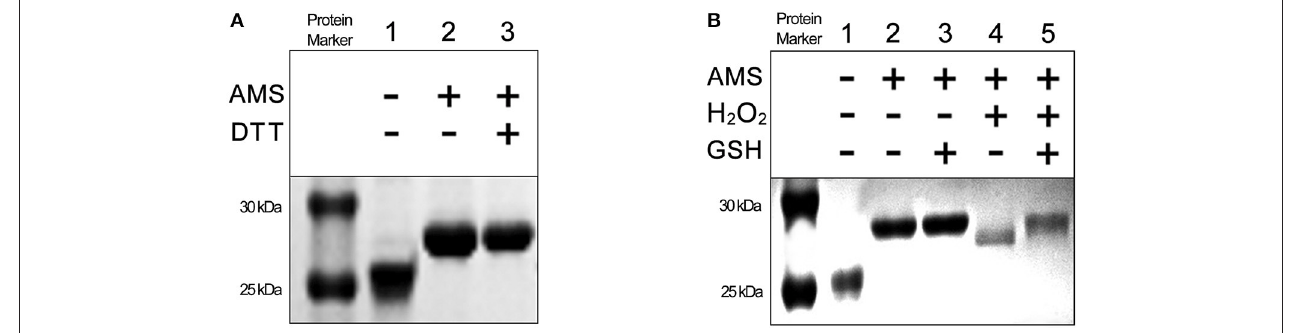
FIGURE 6 | The redox state of cysteine thiol groups in Vfr under reducing and oxidizing conditions. Free thiol groups were covalently modified with AMS. Protein samples were resolved by using 15% non-reducing SDS-PAGE. (A) Vfr proteins (8 µ M) treated with or without DTT (1mM). (B) Vfr proteins (8 µ M) treated with or without GSH (15mM) and H 2 O 2